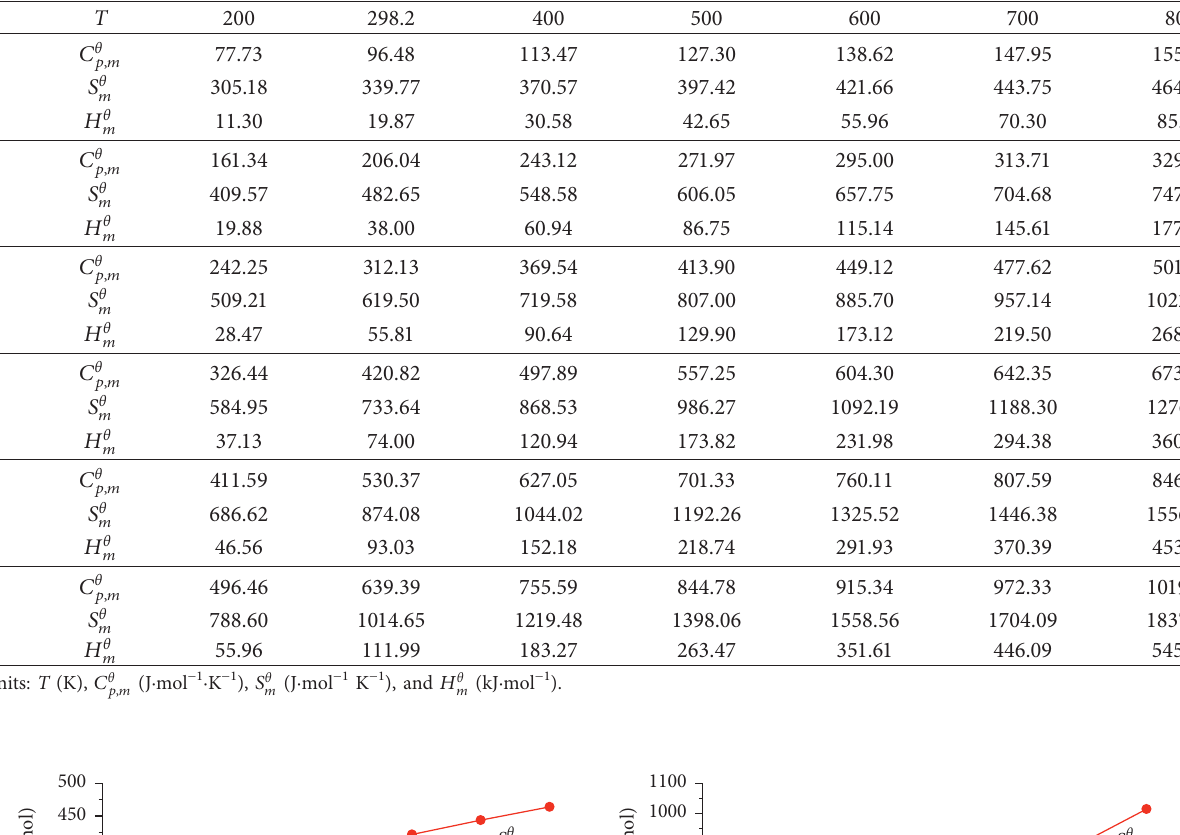
� 1 − 6) at different temperatures a . 3 FBN 3 ) n ( n